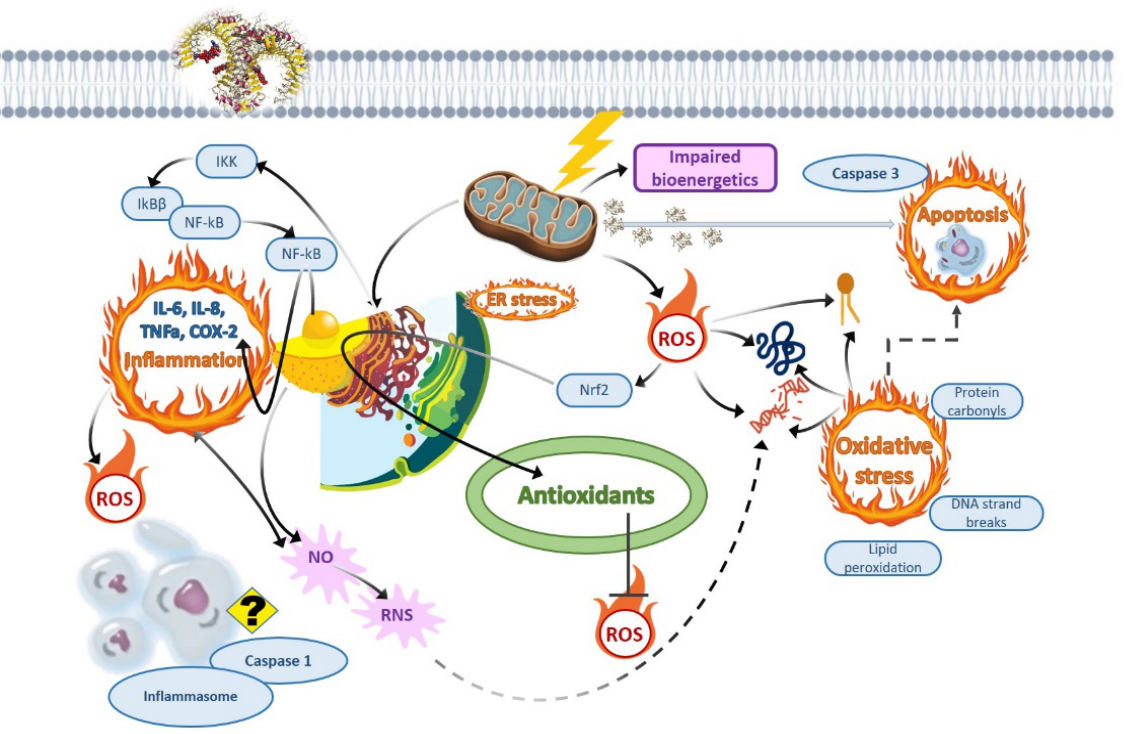
Figure 2. Schematic representation of the potential cellular and molecular events in fish hepatocytes under the action of organophosphate and triazine pesticides.